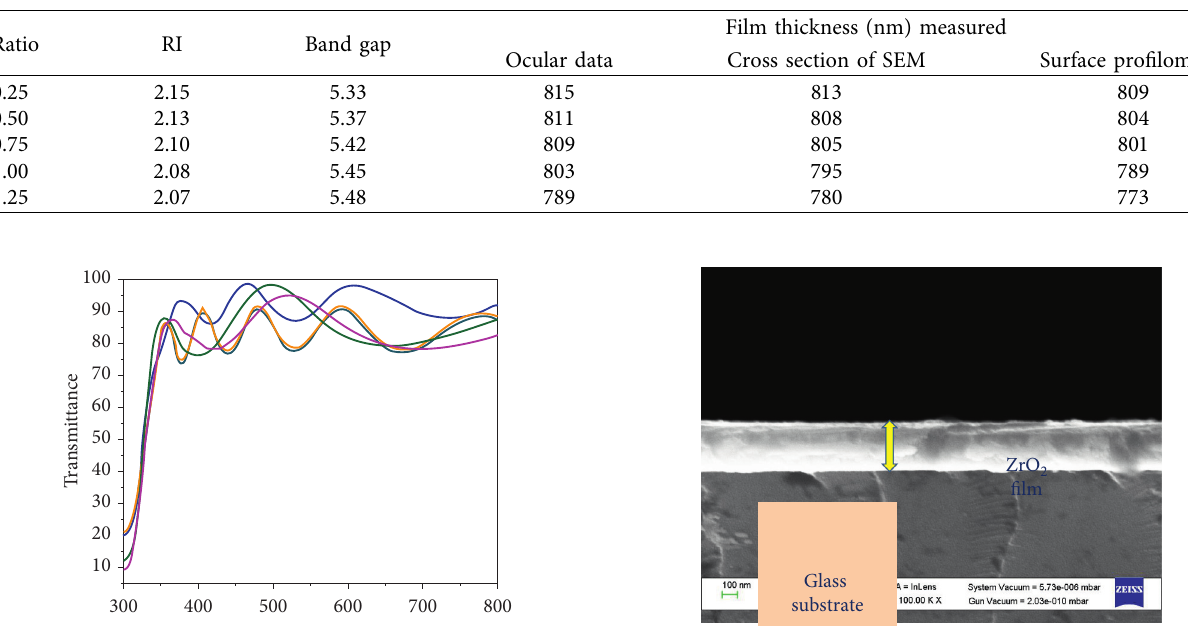
Table 3: Parameters found for ZrO 2 films at various ratios of oxygen/argon.